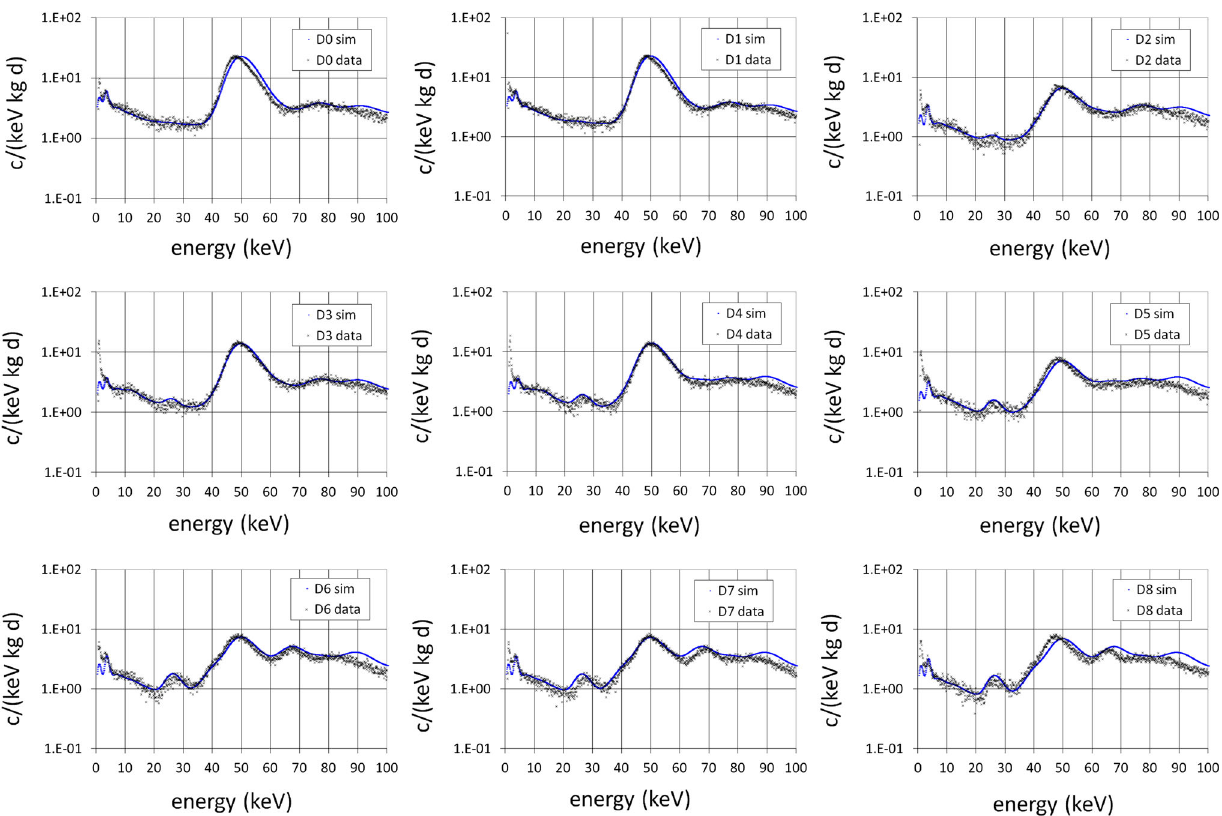
Fig. 10 Comparison of the anticoincidence energy spectra in the low energy range up to 100 keV measured for each detector with the corre- sponding background model summing all the simulated contributions.